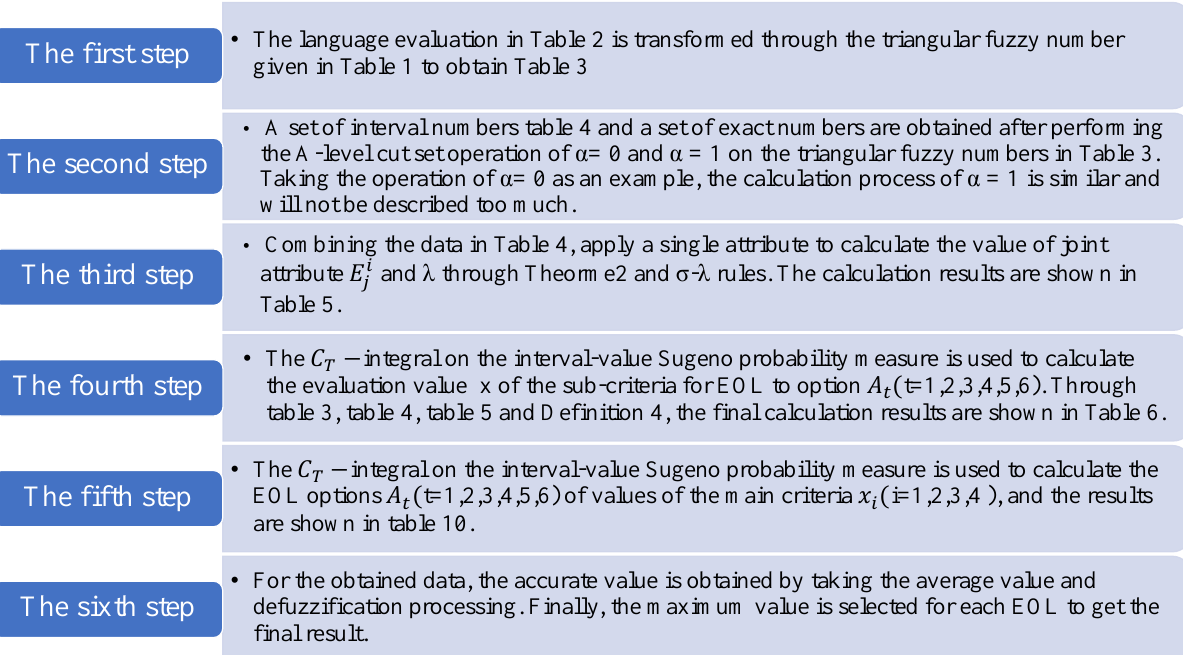
Figure 2. Calculation